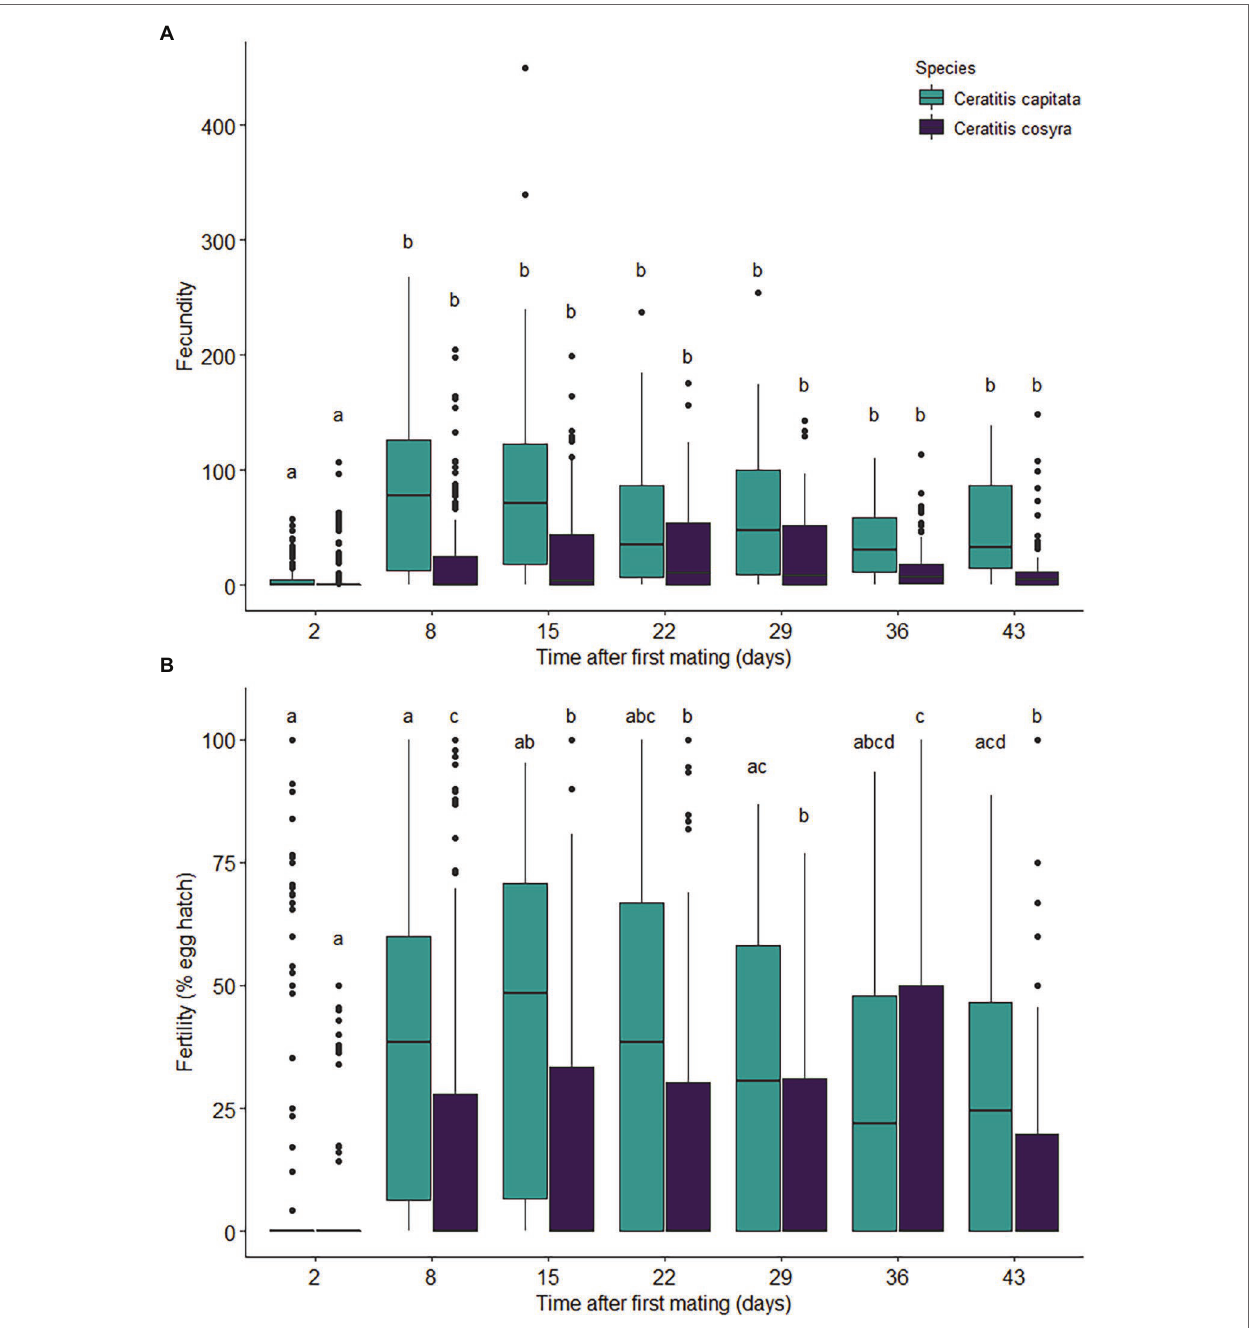
FIGURE 3 | Reproductive effort of C. capitata ( n = 114) and C. cosyra ( n = 140) females kept individually in containers over a 43-day period after mating with a virgin male of peak reproductive age and provided with a fresh oviposition substrate each week. The values displayed are the (A) number of eggs laid (fecundity) and (B) percentage of eggs that hatched (fertility). Time intervals within species with the same lowercase letter are not significantly different (Tukey’s HSD post- hoc tests, α =